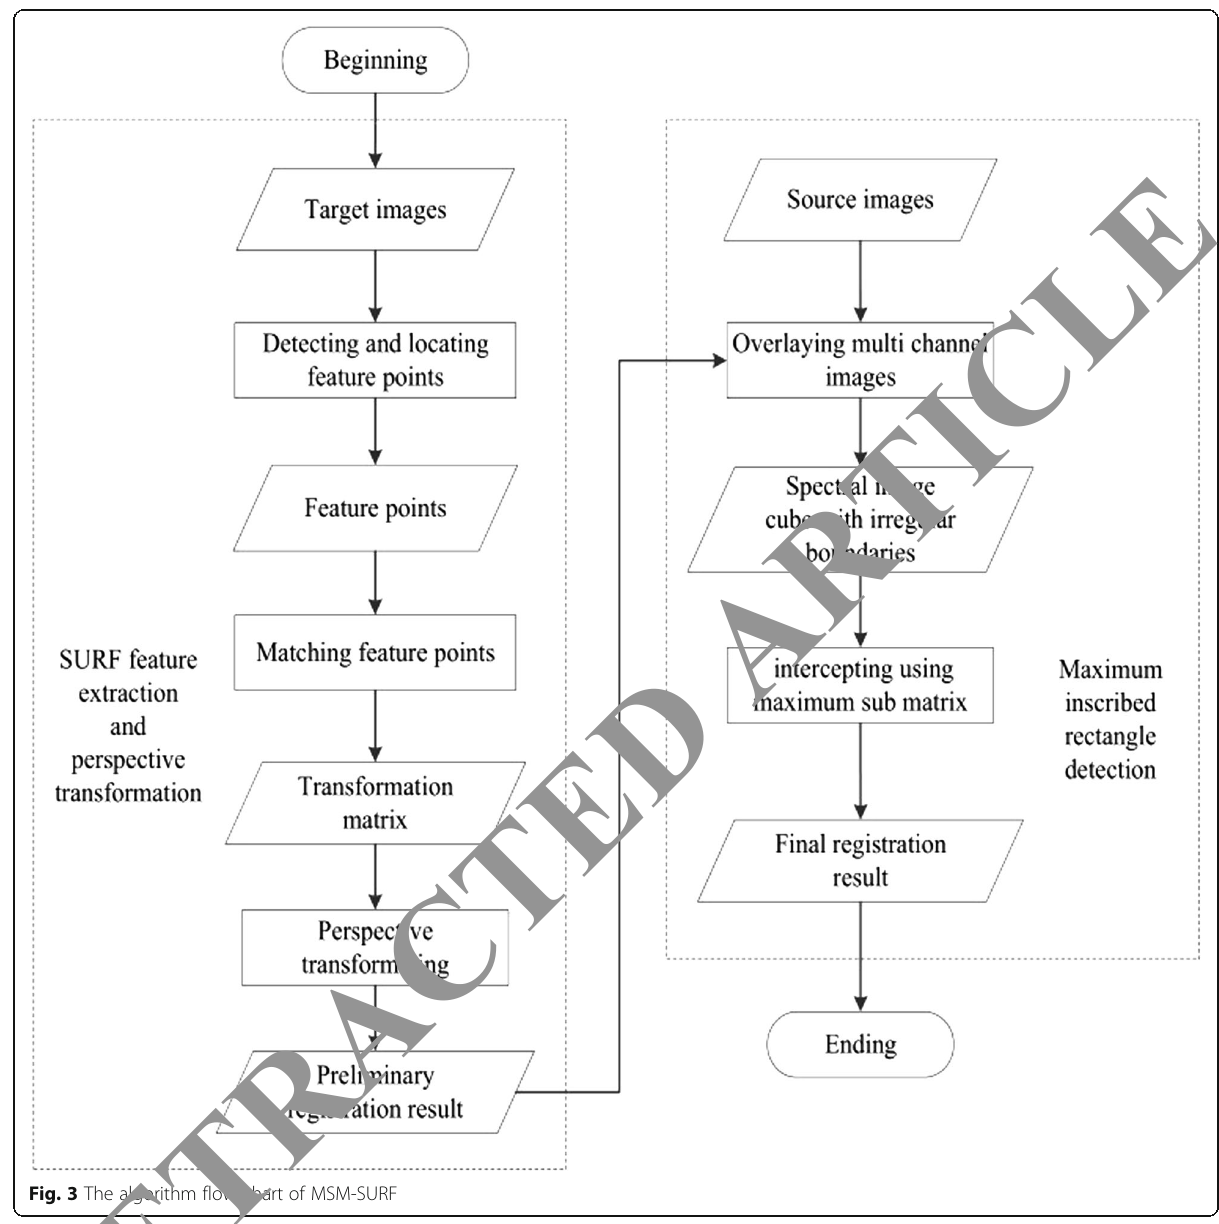
Fig. 3 The algorithm flow chart of